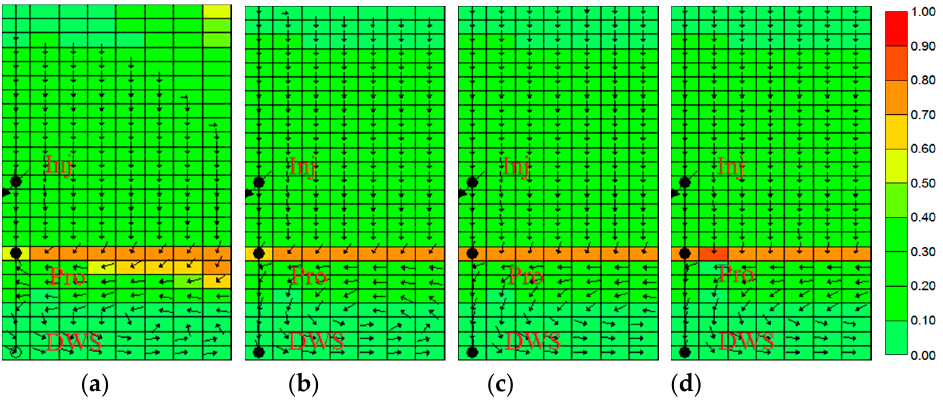
Figure 16. Water flow direction near the wells for the DWS well pattern at a pressure constraint of 3428 kPa: ( a ) production after 1 year; ( b ) production after 2 years; ( c ) production after 3 years; and ( d ) production after 5 years.